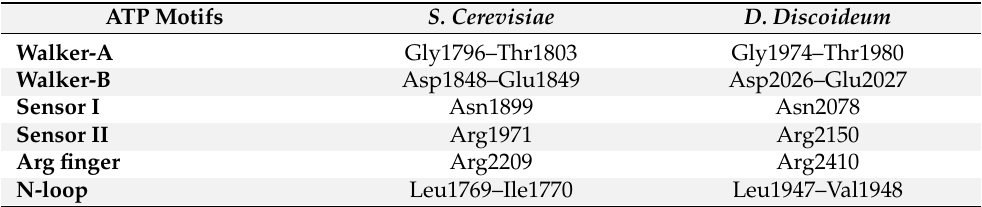
Table 3. The ATP motifs in S. cerevisiae and D. discoideum